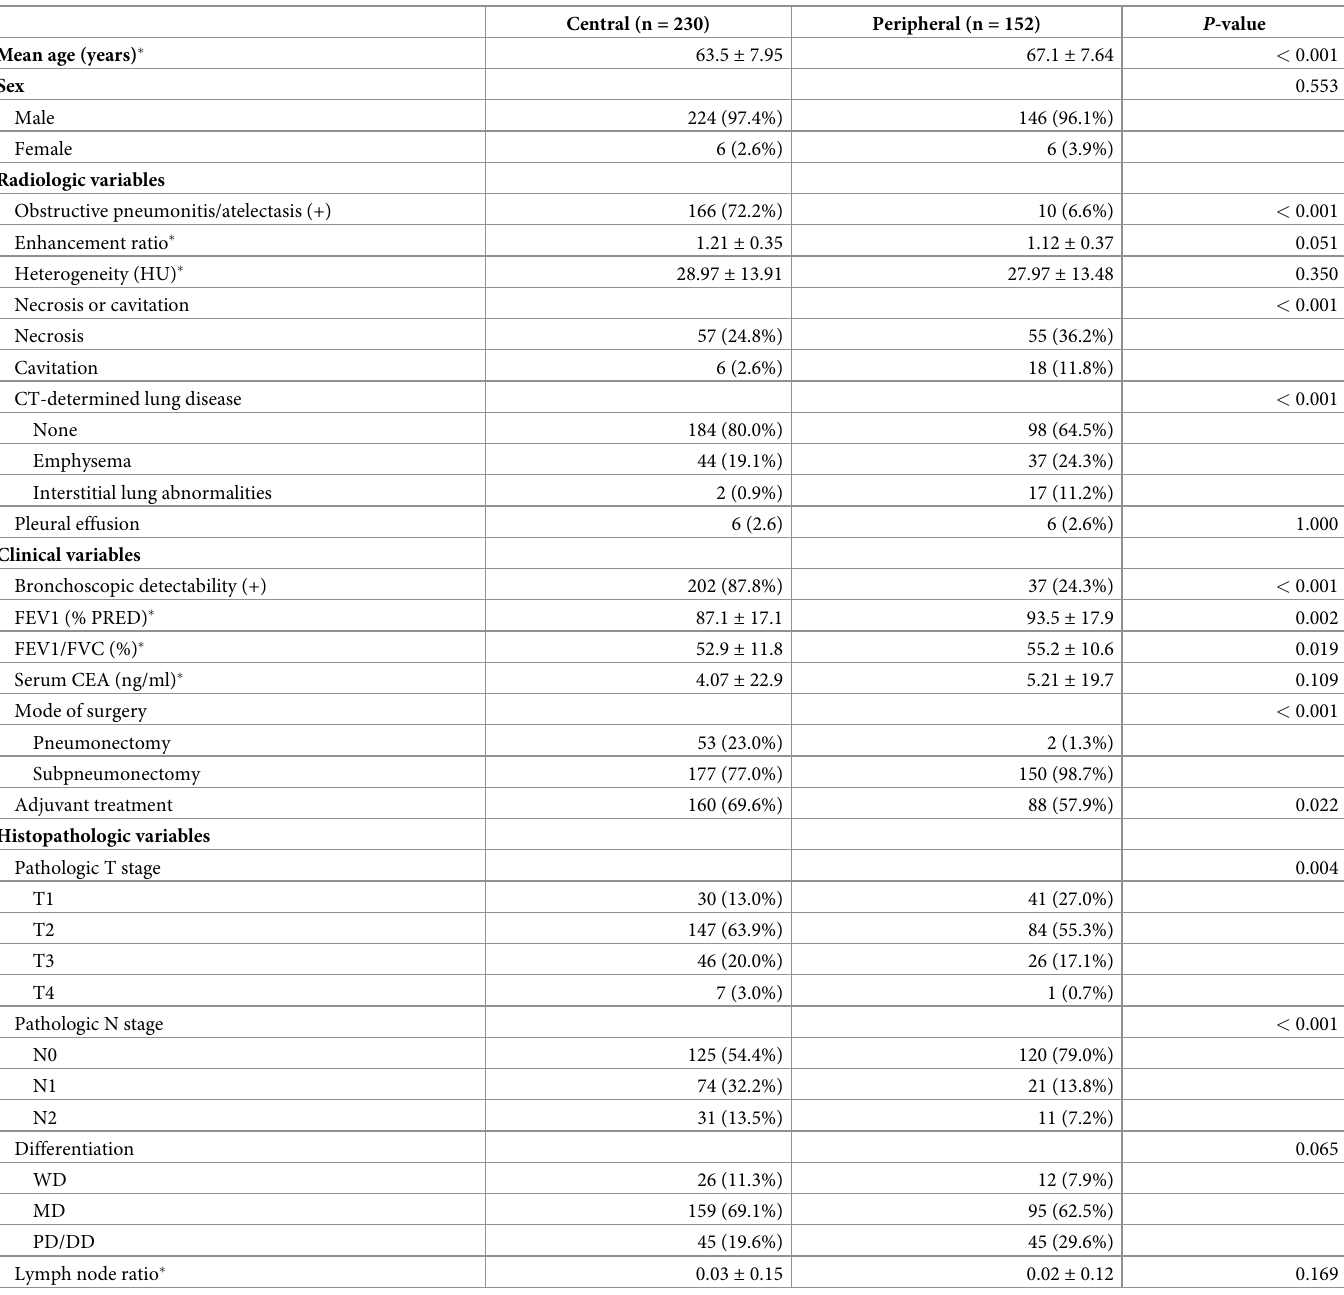
Table 4. Differences between central and peripheral